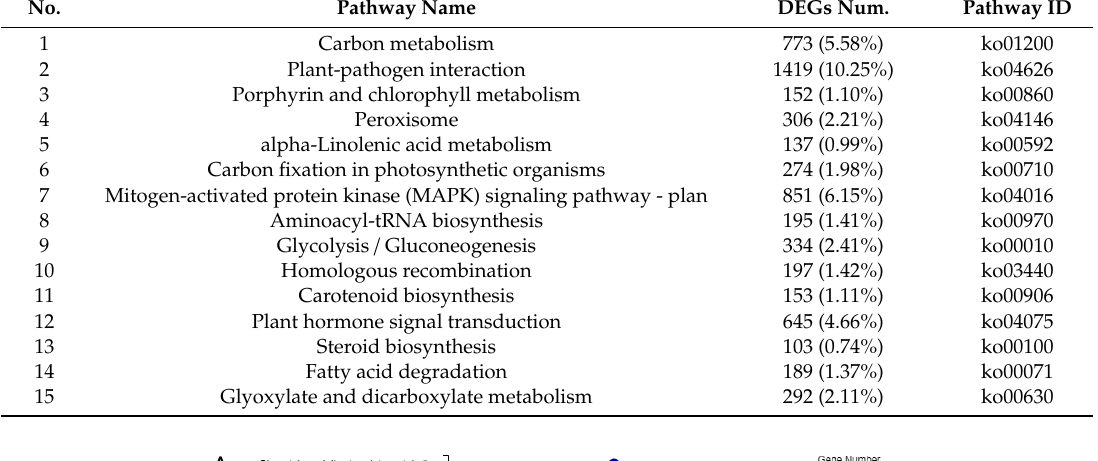
Table 2. Kyoto encyclopedia of genes and genomes (KEGG) pathways with pathway identity information.